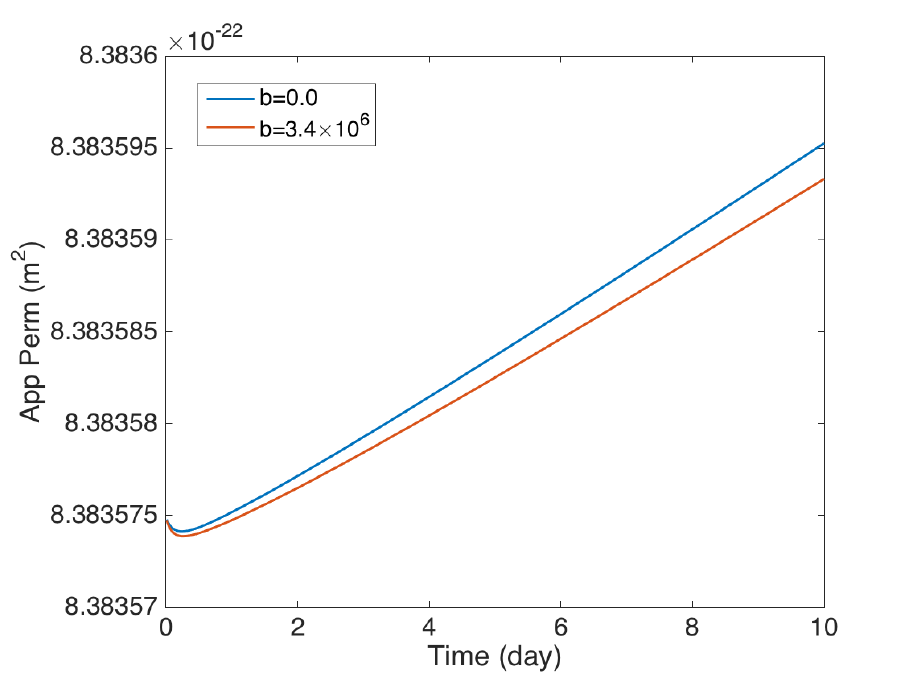
Figure 6. The average apparent permeability for various values of the coefficient b.